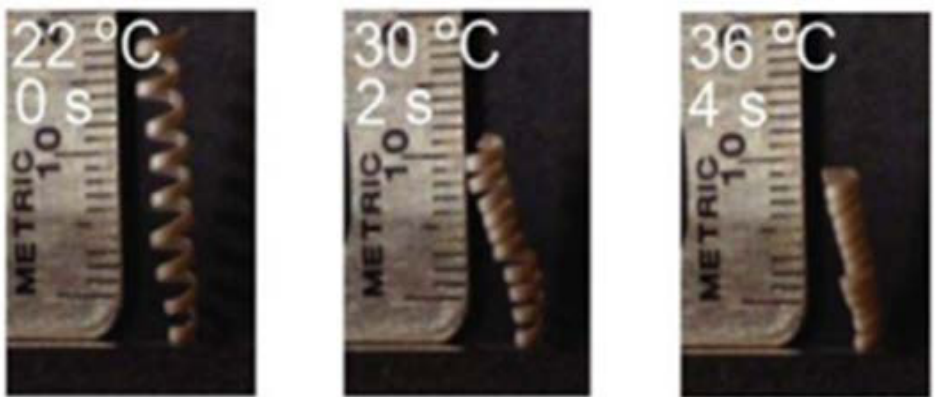
Figure 16. A simple TFAM experiencing thermal actuation (Reprinted with permission from Leng, X., et al. [26] Copyright 2020, CC BY NC ND 4.0 International).